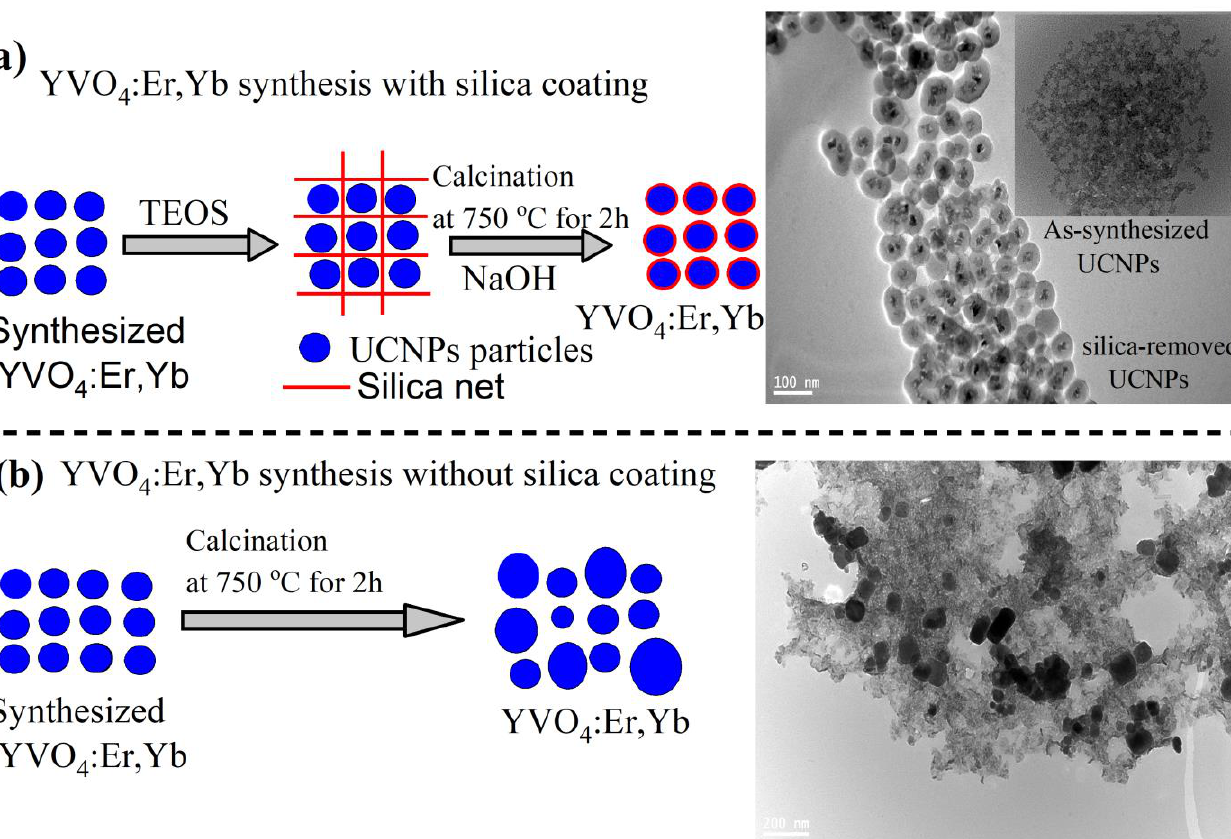
Figure 1. An illustration of high-temperature calcination of YVO 4 :Yb,Er UCNPs. ( a ) Protected calcination of UCNPs by silica coating resulting in well size-controlled and dispersed UCNPs particles. ( b ) Direct calcination process of the UCNPs to 750 °C for 2 h without silica coating, which results in a large size distribution and agglomerated UCNPs.